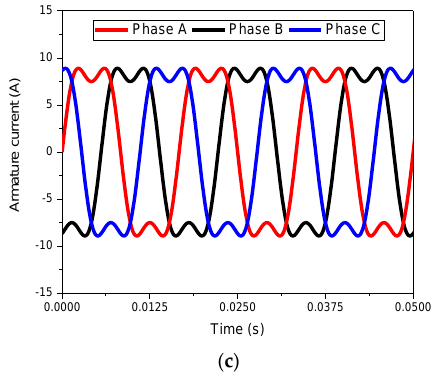
Figure 3. ( a ) Three-phase inverter, ( b ) single-phase inverter, and ( c ) armature currents.